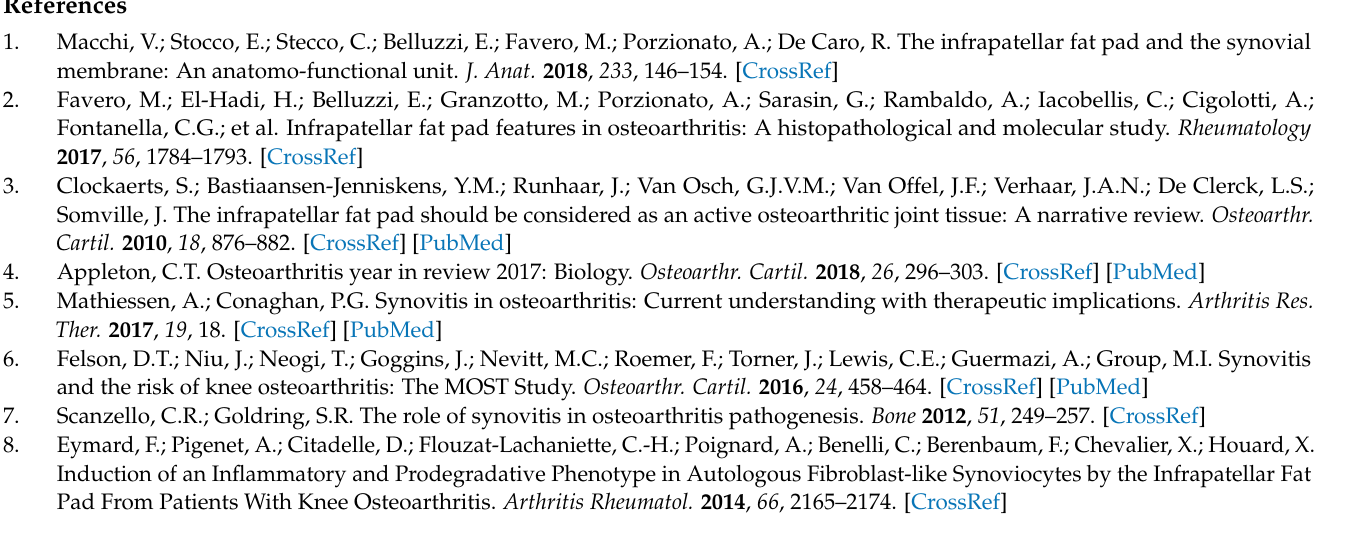
marker genes related to distinct M1, M2-like and typical M2 macrophages subsets, overlaid on the UMAP visualization dot plot. Gene expression levels depicted from gray (low) to purple (high). Figure S2: Expression levels of individual transcripts consisting of M1, typical M2, and M2-like macrophage signatures in Diseased (D), Treated (T), and Healthy (H)